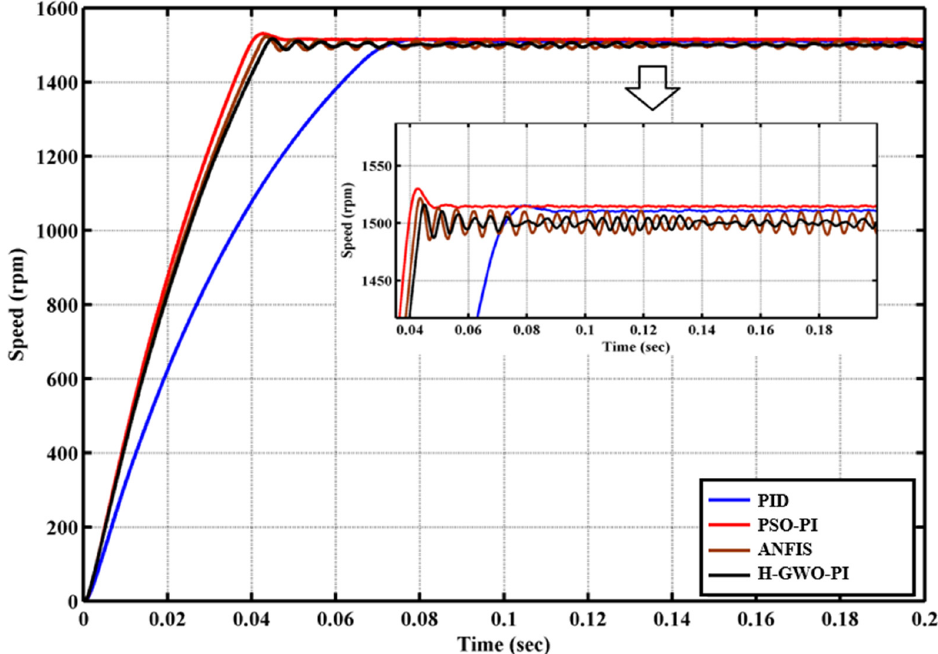
Figure 9. The speed response of a brushless DC motor for No-load. Table 1. No-load condition’s performance